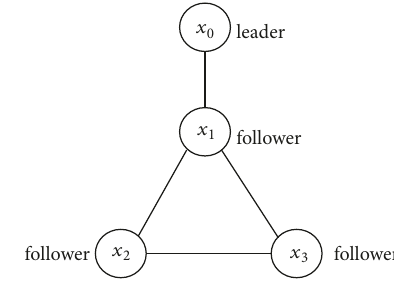
Figure 2: The topological structure of one leader and 3 followers.